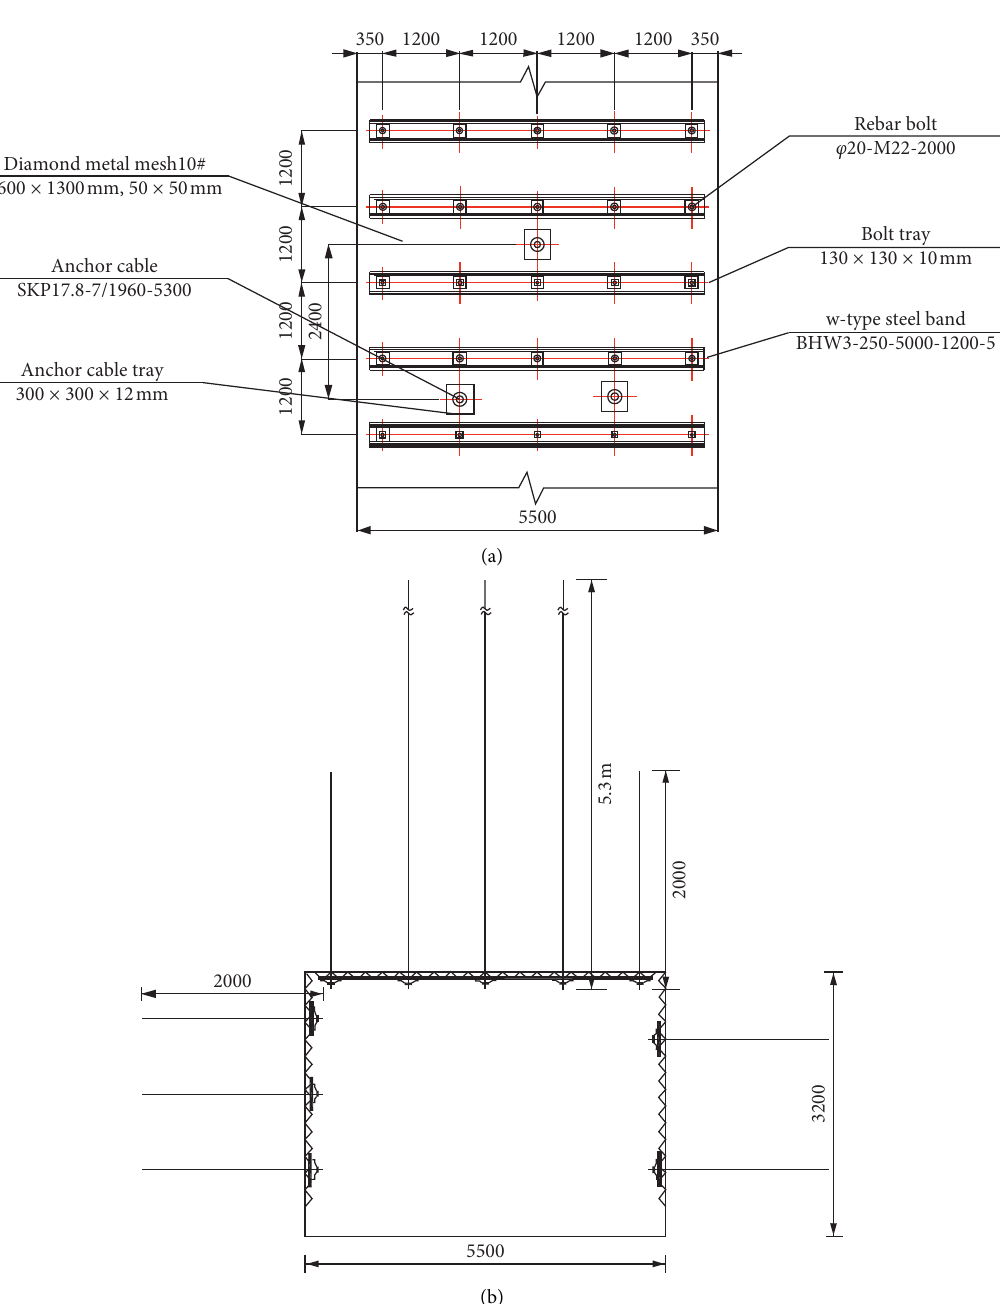
Figure 9: New support scheme for air-return roadway